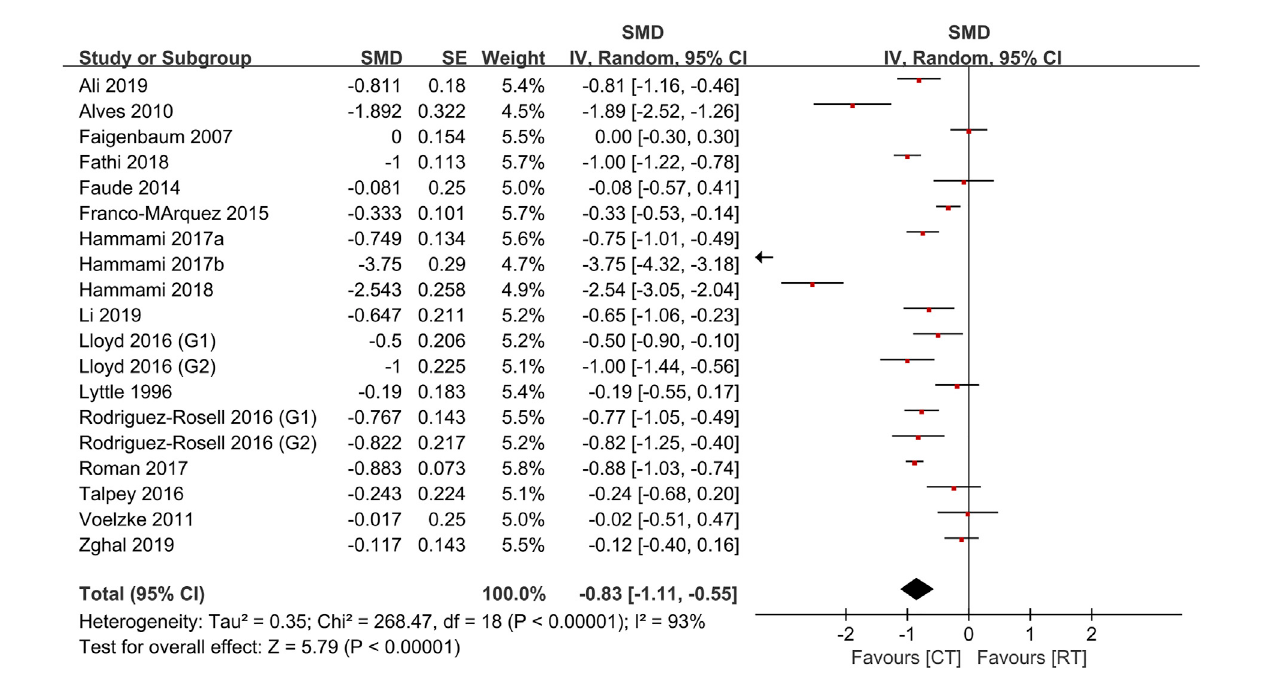
FIGURE 5 Effects of complex training (PLT) on sprint performance.